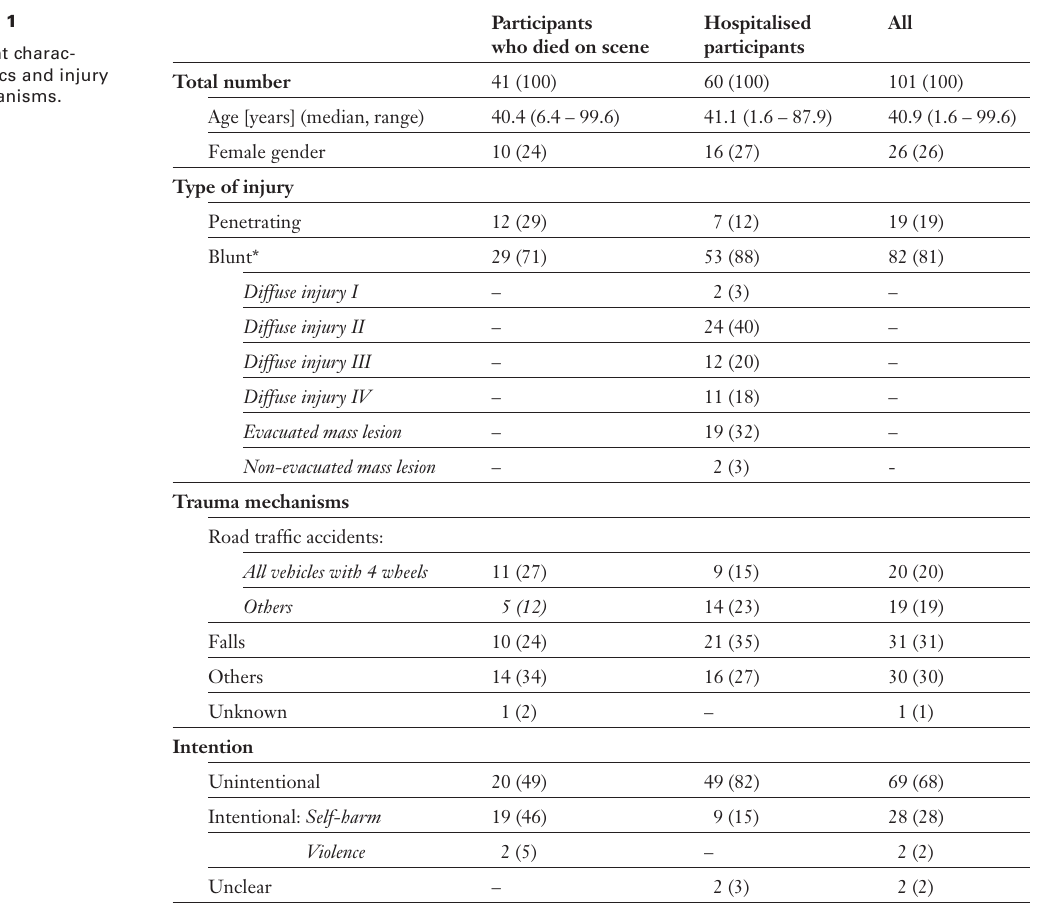
Table 1 Patient charac- teristics and injury mechanisms.